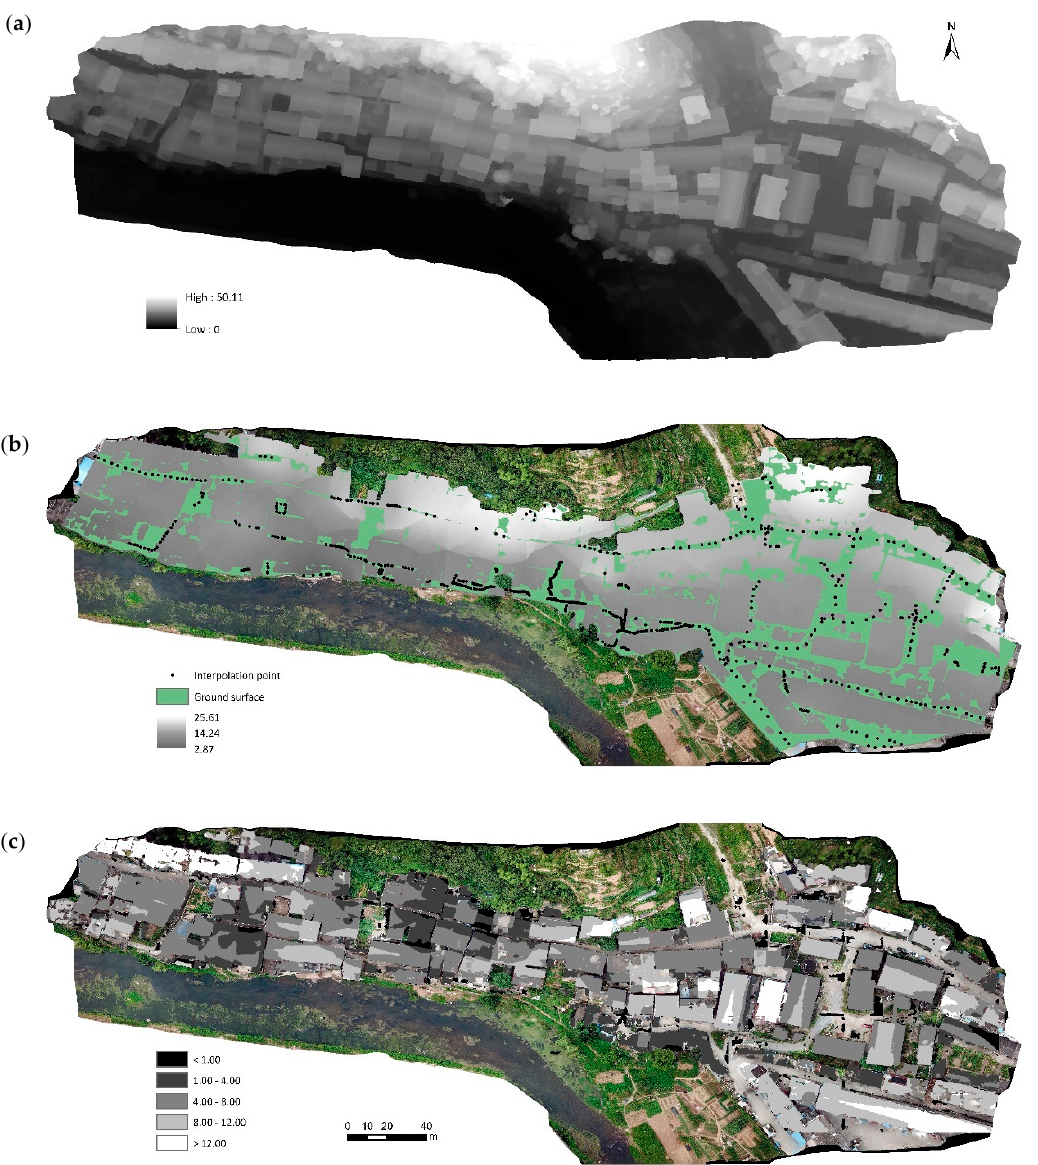
Figure 5. UAV-based estimates of the number of floors in rural buildings. ( a ) Digital terrain model (DTM) built based on the SfM method from the UAV images, ( b ) digital surface model (DSM) based on kriging interpolation with 633 control points, and ( c ) building height model (BHM) divided into di ff erent floors (unit: